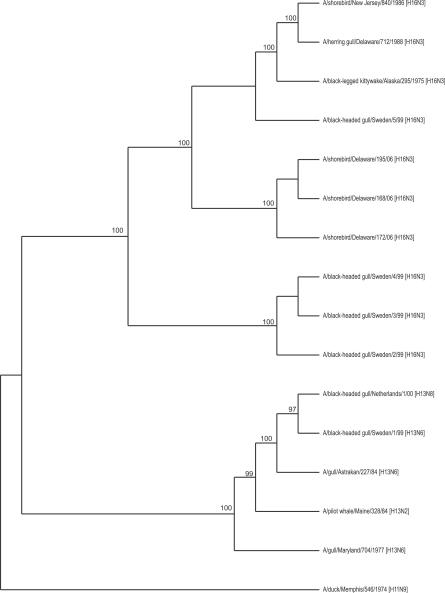
Phylogenetic Tree for the HA Gene (Nucleotides 35–1729) of H13 and H16 Influenza A VirusesThe nucleotide sequences were analyzed by PHYLIP 3.66 software [41] using the neighbor-joining method with 100 bootstraps. The tree was rooted with the A/Duck/Memphis/546/74 (H11) HA sequence.